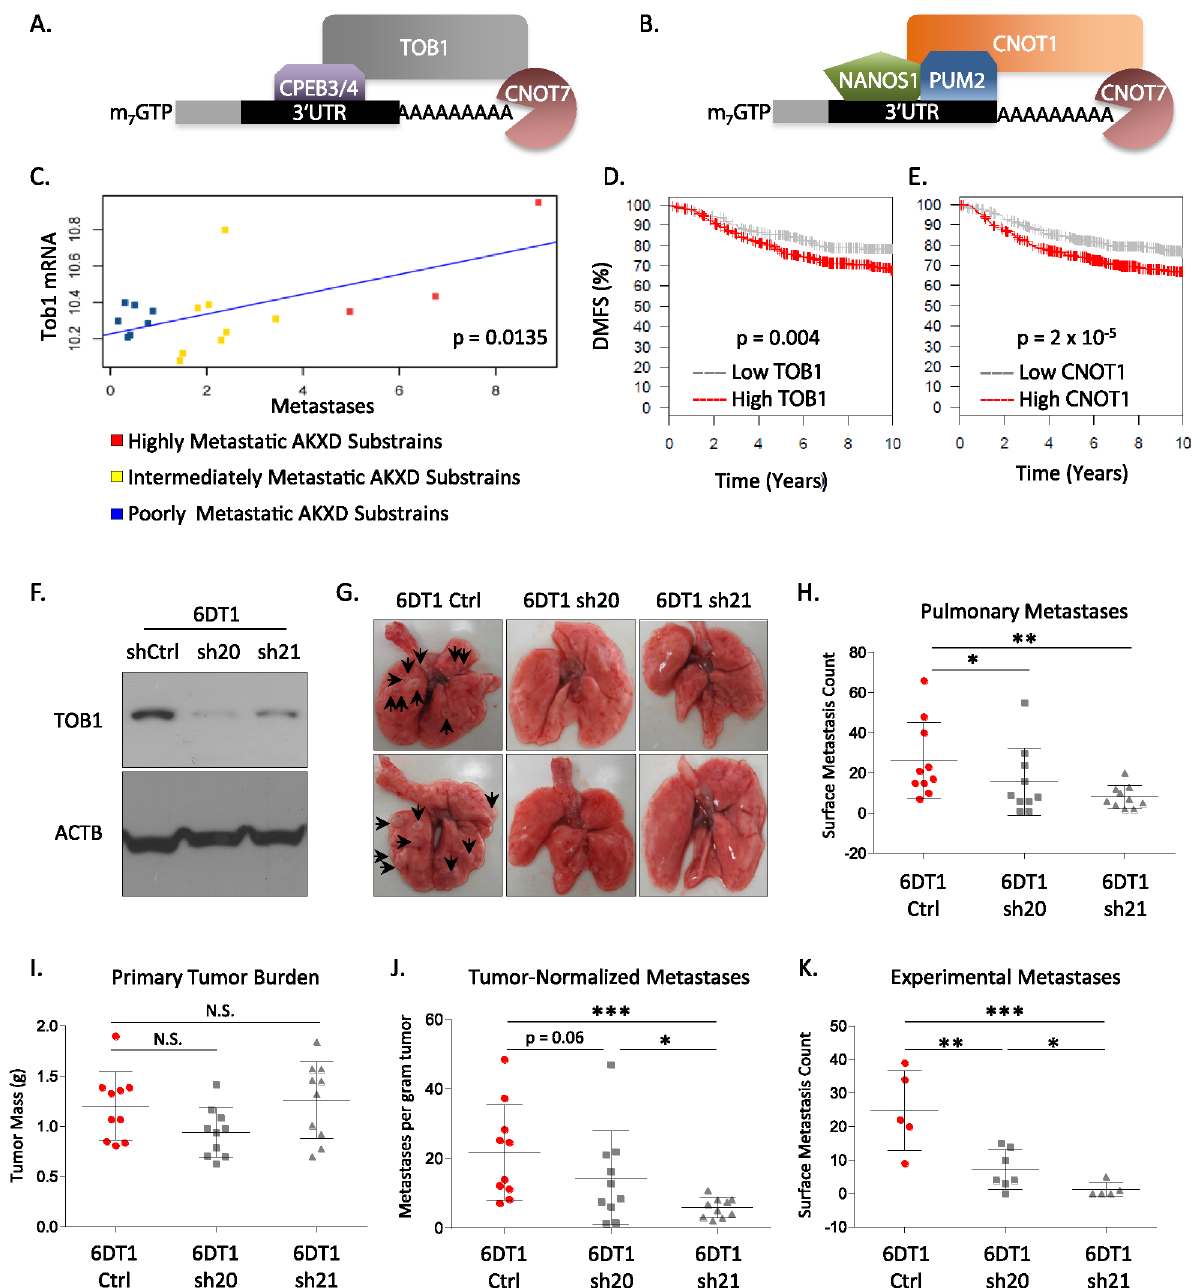
Fig 6. Schematic models of mRNA recruitment to CNOT7 by TOB1 (A) or CNOT1 (B). Correlation plot of Tob1 expression levels with metastatic capacity in the AKXD recombinant inbred mouse panel (C). Kaplan-Meier analysis of the expression of TOB1 (D) or CNOT1 (E) and distant metastasis free survival (DMFS) in the GOBO meta-dataset. Western blot demonstrating the reduction of TOB1 mRNA levels by shRNA knockdown (F). Representative whole mounts of lungs from the Tob1 knockdown spontaneous metastasis assay (G). Dot plots for surface pulmonary metastases from the Tob1 knockdown spontaneous metastasis assay (H). Primary tumor burden for the orthotopically implanted tumors in the Tob1 knockdown assay (I). Surface pulmonary metastases for the Tob1 knockdowns after normalization by primary tumor weight (J). Dot plots of pulmonary metastases for the experimental tail vein injection assay (K). N.S. = not significantly different. * = p < 0.05; ** = p < 0.01; *** = p <